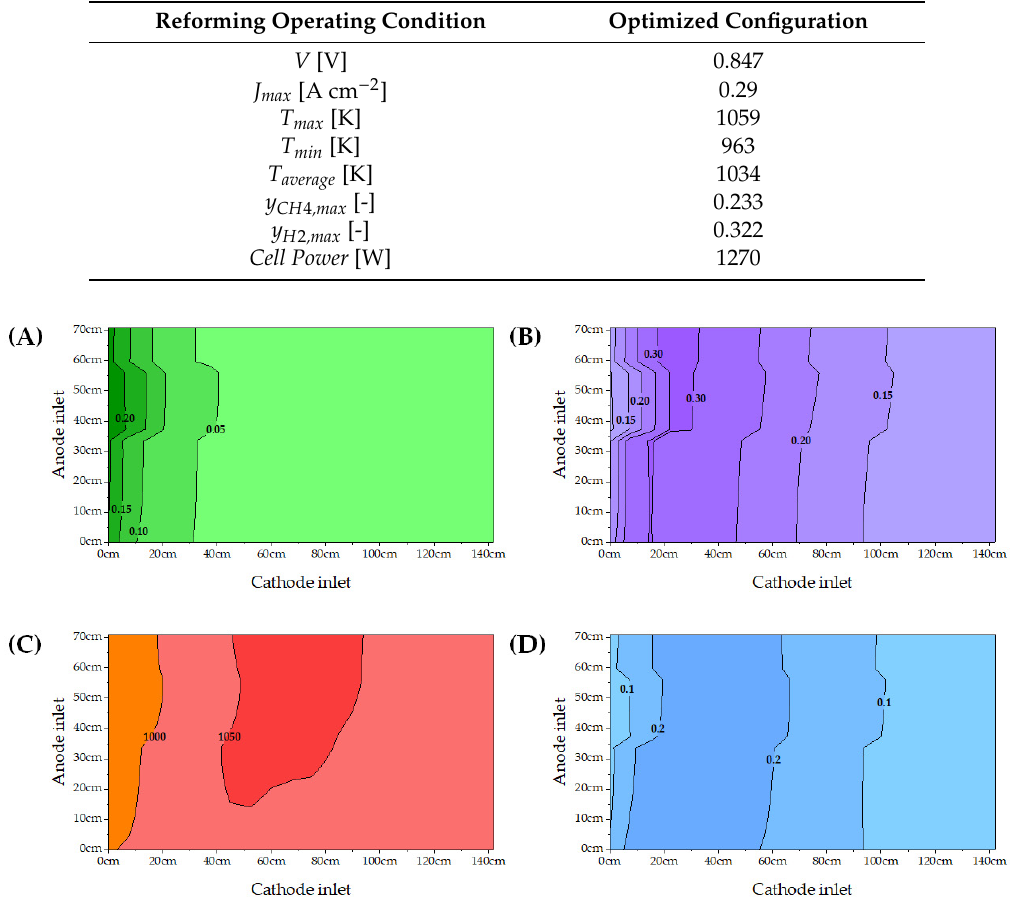
Table 7. Main results of the simulation using local maps of σ to optimize cell performance.